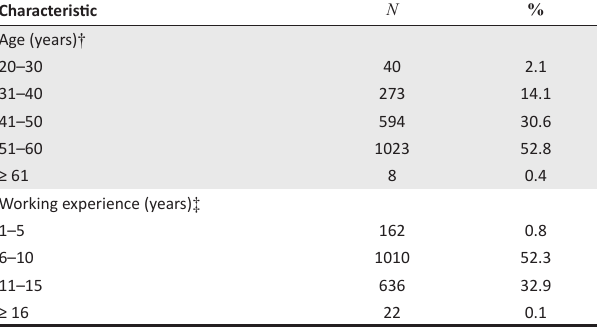
TABLE 1: Demographic characteristics of the miners in the main subset ( N =